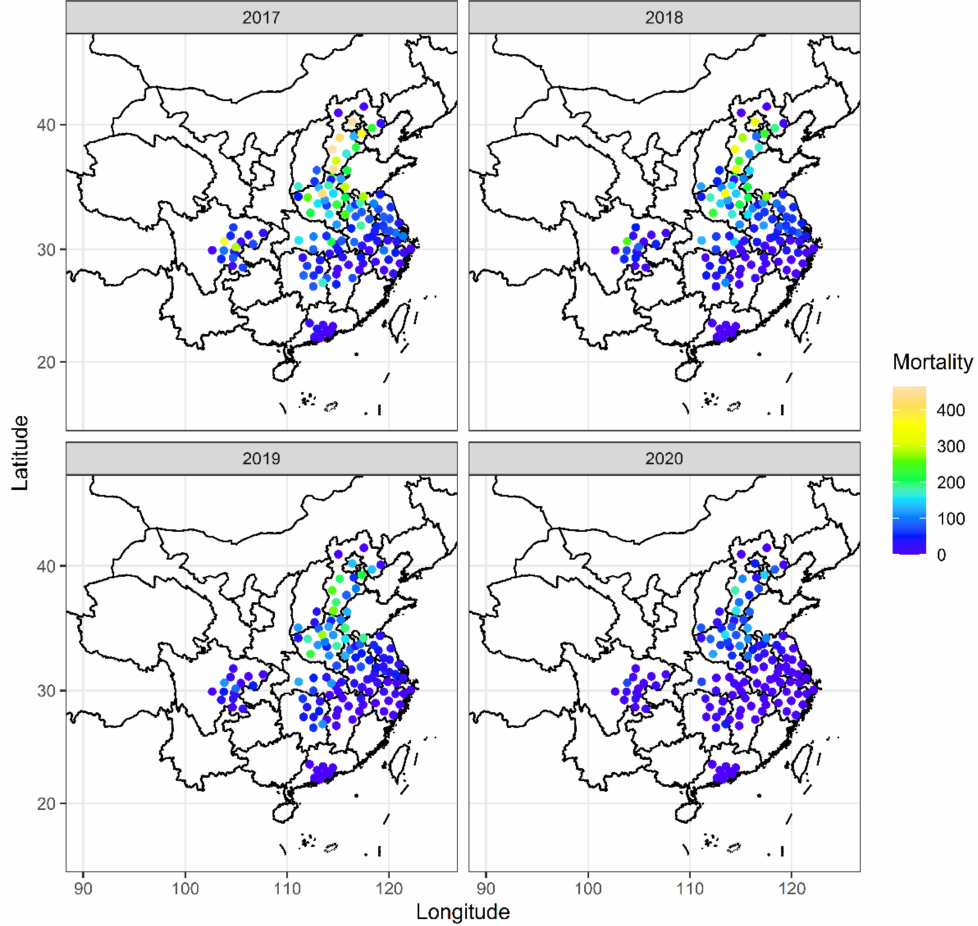
Figure 9. The spatial distributions of premature mortality for respiratory disease attributed to PM 2.5 exposure in six urban agglomerations, from 2017 to